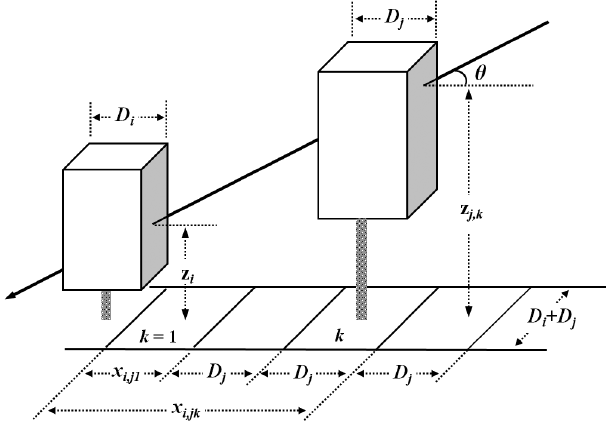
Figure 3. The scheme to calculate the shading effects of neighbour- ing plants in the